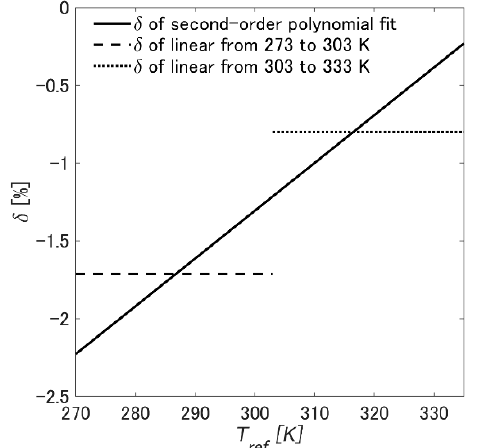
δ , at each reference temperature, T